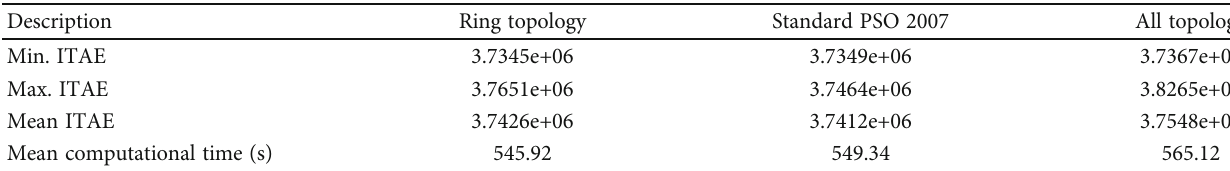
Table 6: Comparison of standard PSO 2007 with di ff erent